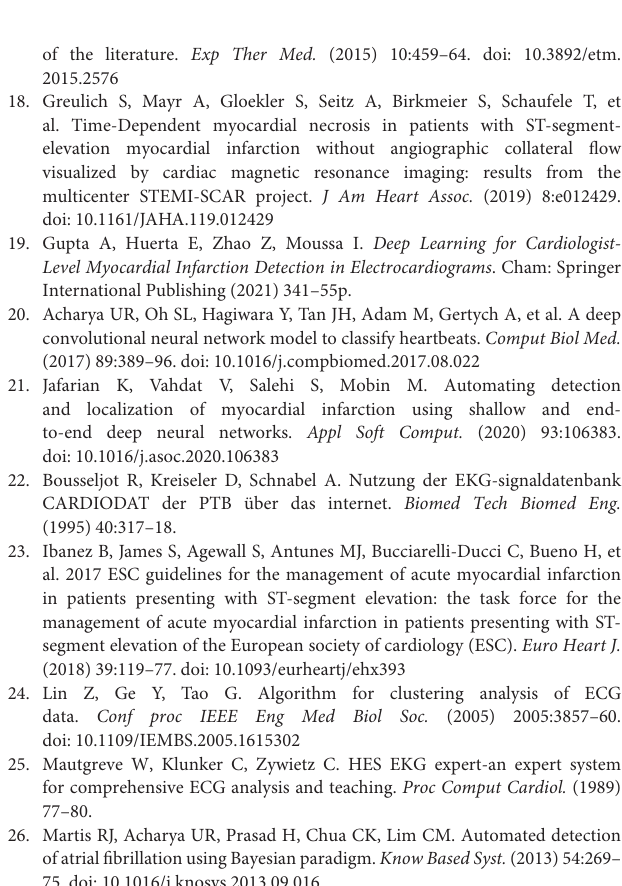
Supplementary Figure 1 | The Receiver-operating characteristic curves for automatic acute myocardial infarction location diagnosis in the testing set. Supplementary Table 1 | The ECGs diagnosed with false-negative results in the validation and testing set. Supplementary Table 2 | The deep learning model performance in predicting the MI location in the testing